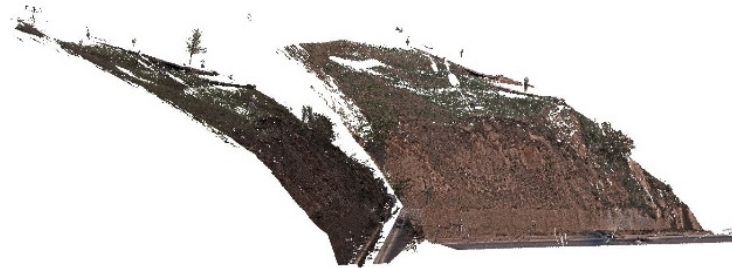
Figure 19. Initial point cloud of landslide in two phases.